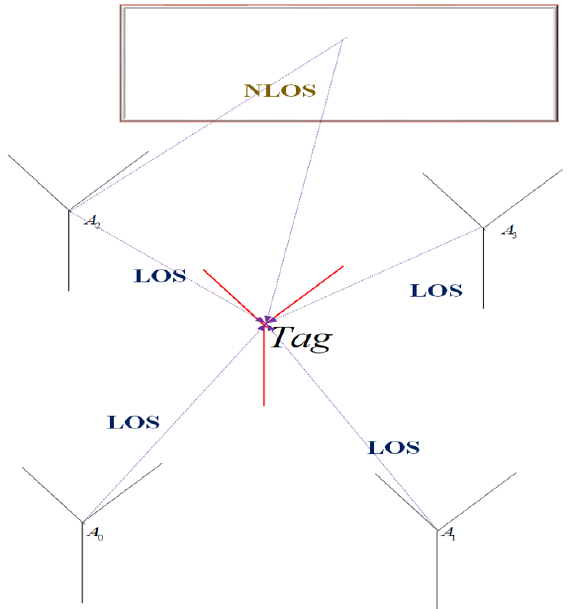
Figure 4. NLOS problem: In the absence of LOS in TOF-based ranging between MN and AP, the estimated range is larger than the true